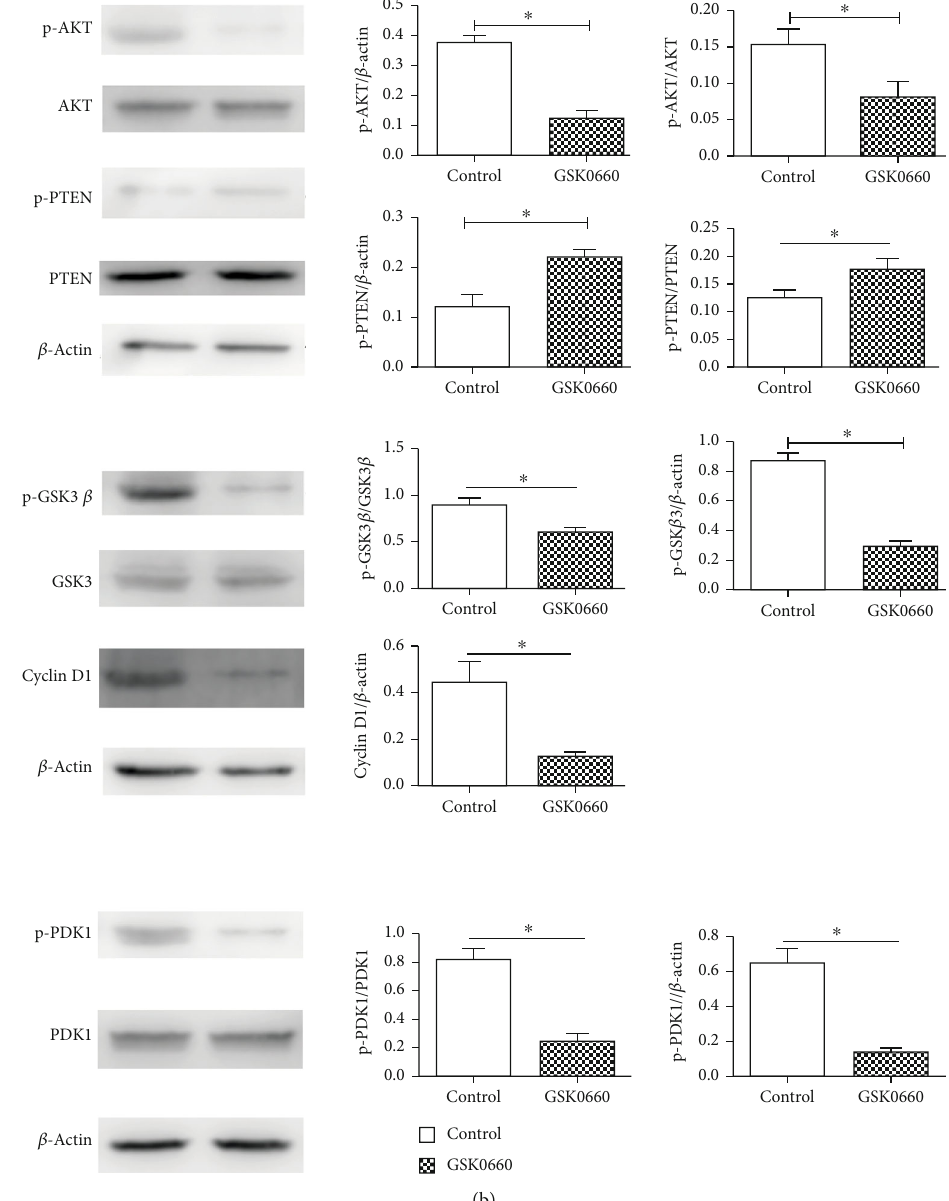
Figure 4: Ligand activation of PPAR β / δ had e ff ect on PDK1/PTEN/AKT/GSK3 β /Cyclin D1 signal pathway in cultured cholesteatoma keratinocytes. (a) Western blot showing changes in PDK1/PTEN/AKT/GSK3 β /Cyclin D1 pathway after treating with 100 nM GW0742 for 24h. (b) Immunoblots demonstrating the e ff ect of GSK0660 treatment (5 μ M, 24h) on the PDK1/PTEN/AKT/GSK3 β /Cyclin D1 pathway. β -Actin served as loading control. ∗ p < 0 : 05